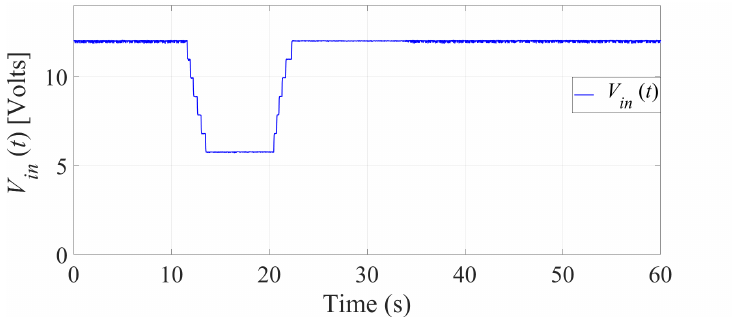
Figure 19. Input voltage V in ( t ) to test the closed-loop system implementing a classical PID